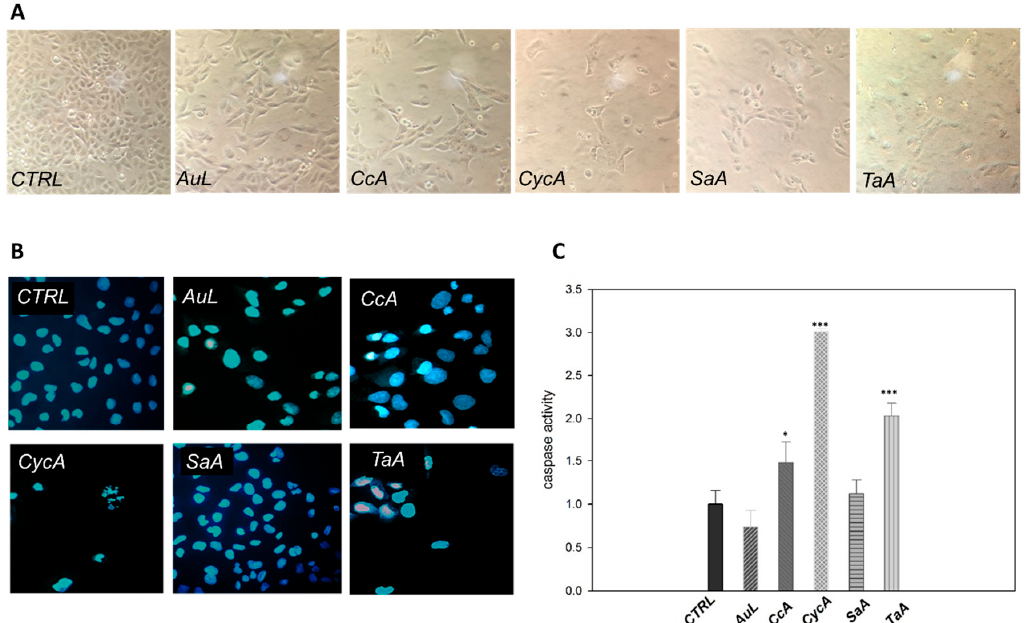
Figure 3. Apoptotic effects on U2OS cells treated for 48 h with the selected extracts: morphological changes and caspase activity. ( A ) Images acquired by optical microscope. ( B ) Images acquired by fluorescence microscope after HOECHST staining. (All the images were taken at the same magnification and depict microscopic fields representative of the whole cell population.) ( C ) Caspase activity assay (fold change of protein activity was calculated by taking untreated cells as a control = 1). Bar graphs represent means ± SD determined from at least three independent experiments. Di ff erences were considered significant when p ≤ 0.05 (* p ≤ 0.05; *** p ≤